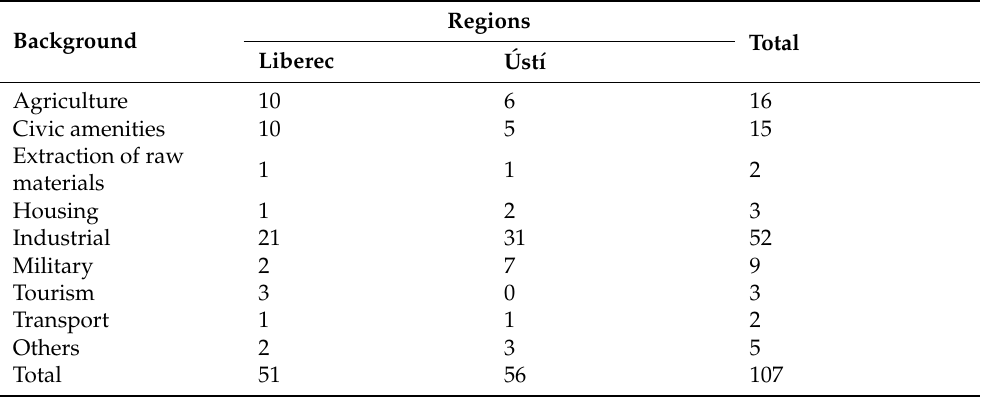
Table 3. Number of brownfields of different origins in the Northern Czech Republic [41].